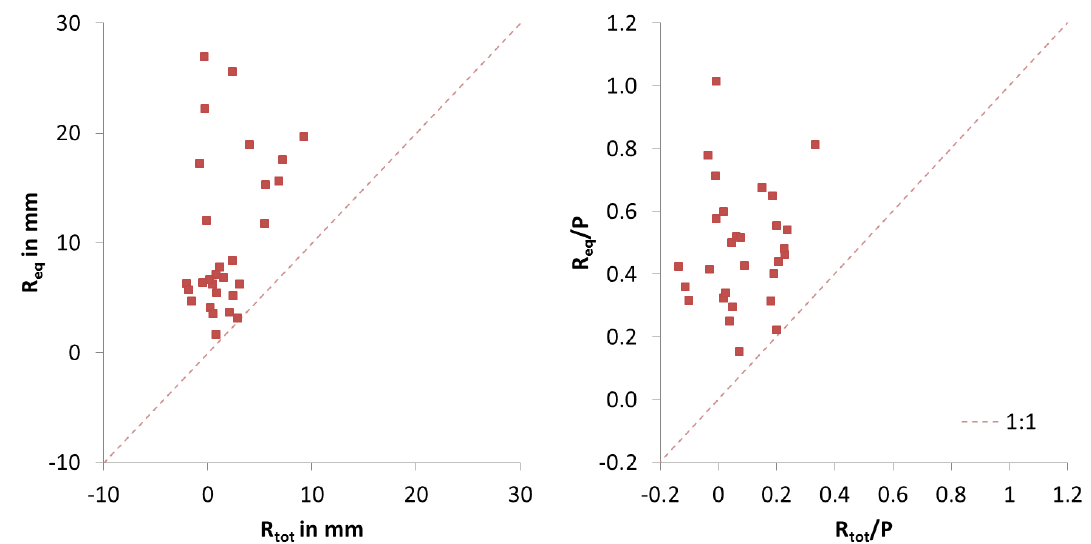
Figure 8. Comparison of runoff estimated under the assumption of quasi-equilibrium soil moisture conditions (R eq ) with the measured runoff R tot in absolute values ( left ) and in relation to the precipitation of the rainfall event ( right ).